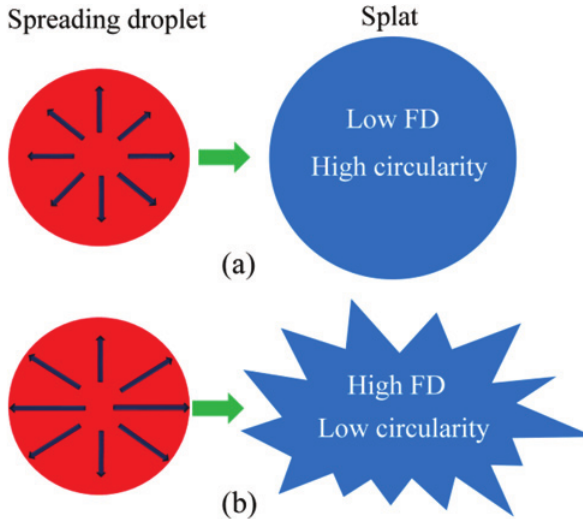
Figure 5: Schematic diagrams of the forming processes of typical morphologies of two splats. The left images present the morpholo- gies of the splats at an early stage of spreading, while the right images present the morphologies of final